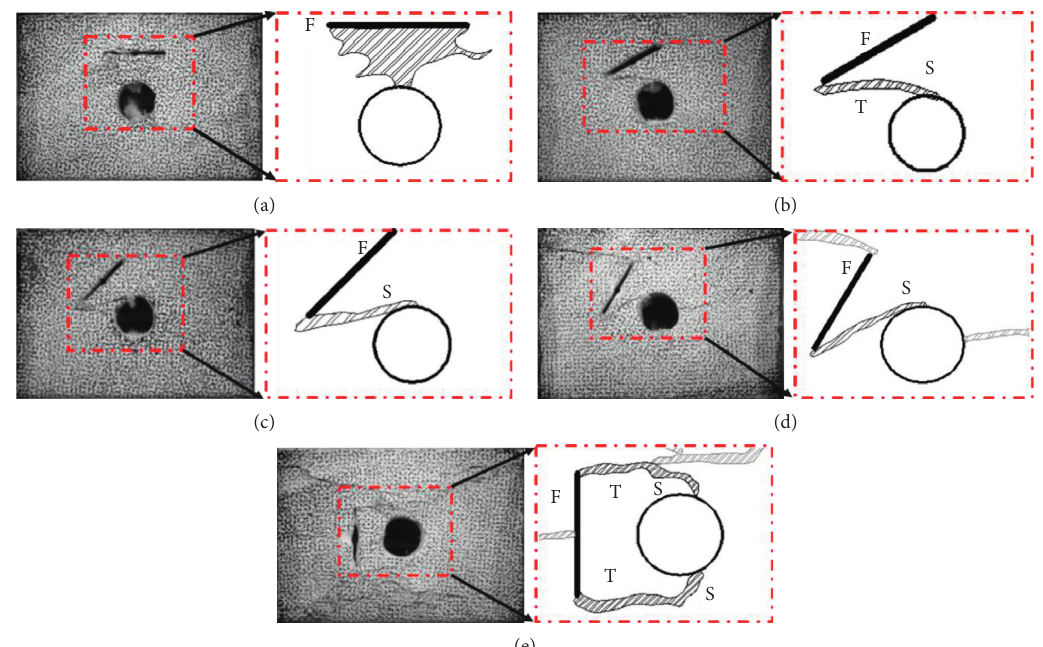
Figure 8: Crack coalescence modes of precracked specimens with different flaw inclination angles of (a) 0 ° , (b) 30 ° , (c) 45 ° , (d) 60 ° , and (e) 90 ° .